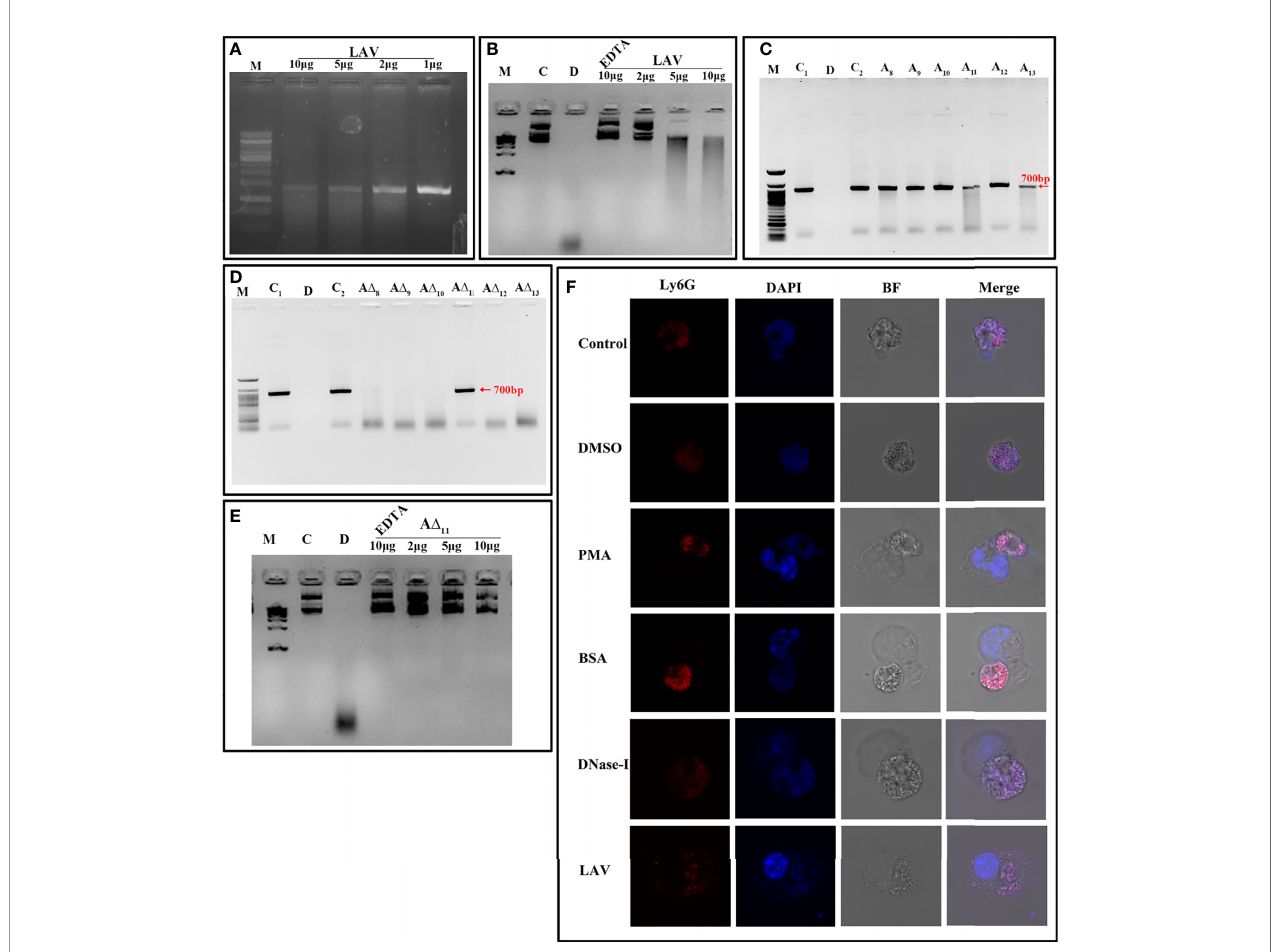
FIGURE 6 | LAV is nuclease capable of degrading Neutrophil Extracellular Trap (NET). (A) Exonuclease activity of the LAV . 700bp DNA (200ng) was incubated with different concentrations of LAV (1, 2, 5 and 10 m g) in DPBS with 5mM MgCl 2 at 37°C for 3h followed by visualized using the EtBr- Agarose gel electrophoresis. (B) Endonuclease activity of the LAV. Plasmid DNA (200ng) was incubated with different concentrations of LAV (2, 5 and 10µg) in DPBS with 5mM MgCl 2 at 37°C for 3h followed by visualized using the EtBr- Agarose gel electrophoresis. (C) Exonuclease activity of the LAV domains. 700bp DNA (200ng) with incubated with various LAV domains (A 8 -A 13 ) at 5µg in DPBS with 5mM MgCl 2 incubated at 37°C for 3h followed by EtBr- Agarose gel electrophoresis. (D) Exonuclease activity of domain deletion mutants of LAV . DNA (200ng) with incubated with various domain deletion mutants of LAV (A Δ 8 -A Δ 13 ) at 5µg in DPBS with 5mM MgCl 2 incubated at 37°C for 3h followed by EtBr- Agarose gel electrophoresis (E) Endonuclease activity of the A Δ 11 . Plasmid DNA (200ng) was incubated with different concentrations of A Δ 11 (2, 5 and 10µg) in DPBS with 5mM MgCl 2 with or without EDTA at 37°C for 3h followed by visualized using the EtBr- Agarose gel electrophoresis. C and C1 indicates DNA alone, D indicates DNA treated with DNase-I, C2 indicates DNA with reaction mixture, M is 100bp or 1kb DNA ladder in all experiments wherever indicated (F) . NETosis assay: Mouse Neutrophils were cultured on imaging dishes stimulated with DMSO or LPS (500ng) or PMA (50ng/ml) for 3h and then treated with DNase-I (positive control) or BSA (negative control) or LAV (5 m g) for 2h at 37°C and visualized under 63X of Leica microscopy. DAPI; staining of the complete DNA content (Nuclear and released), Ly6G; neutrophil marker, BF; Bright fi eld. All data are representative of three independent